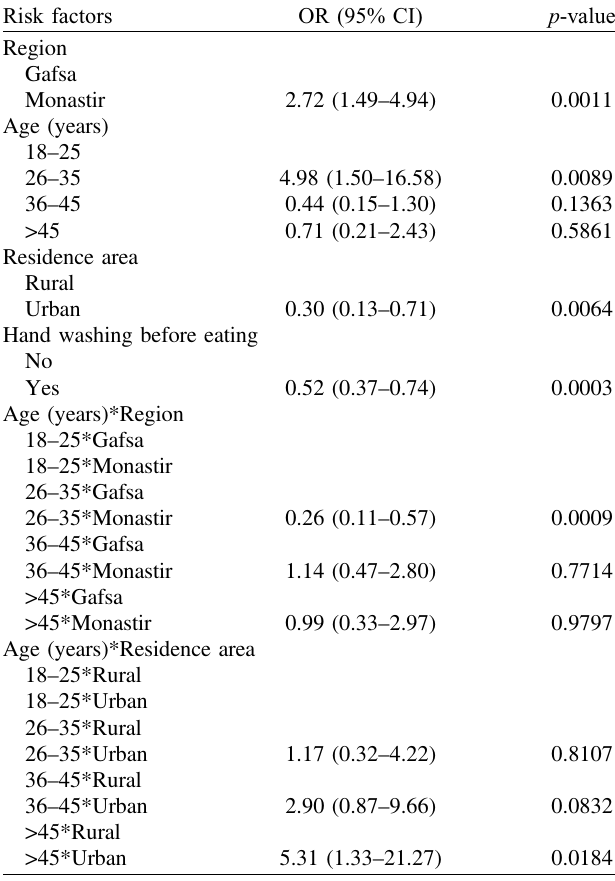
Table 2. Best- fi tting model multivariate of risk factors for Toxoplasma gondii